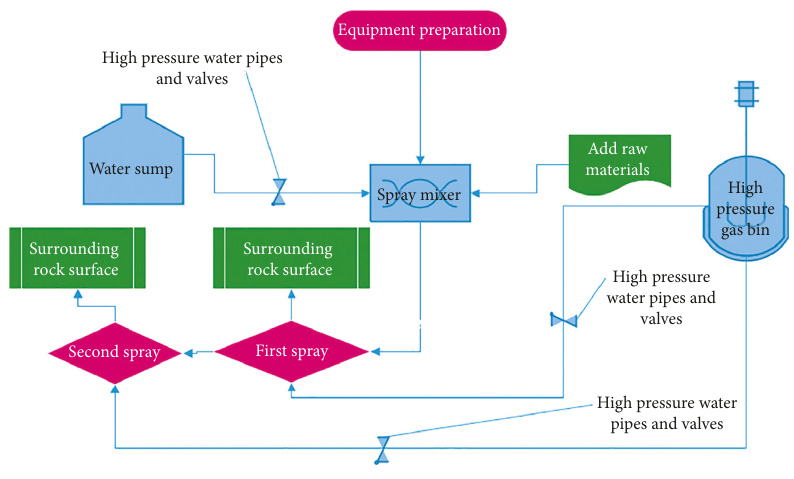
Figure 9: Process flow.